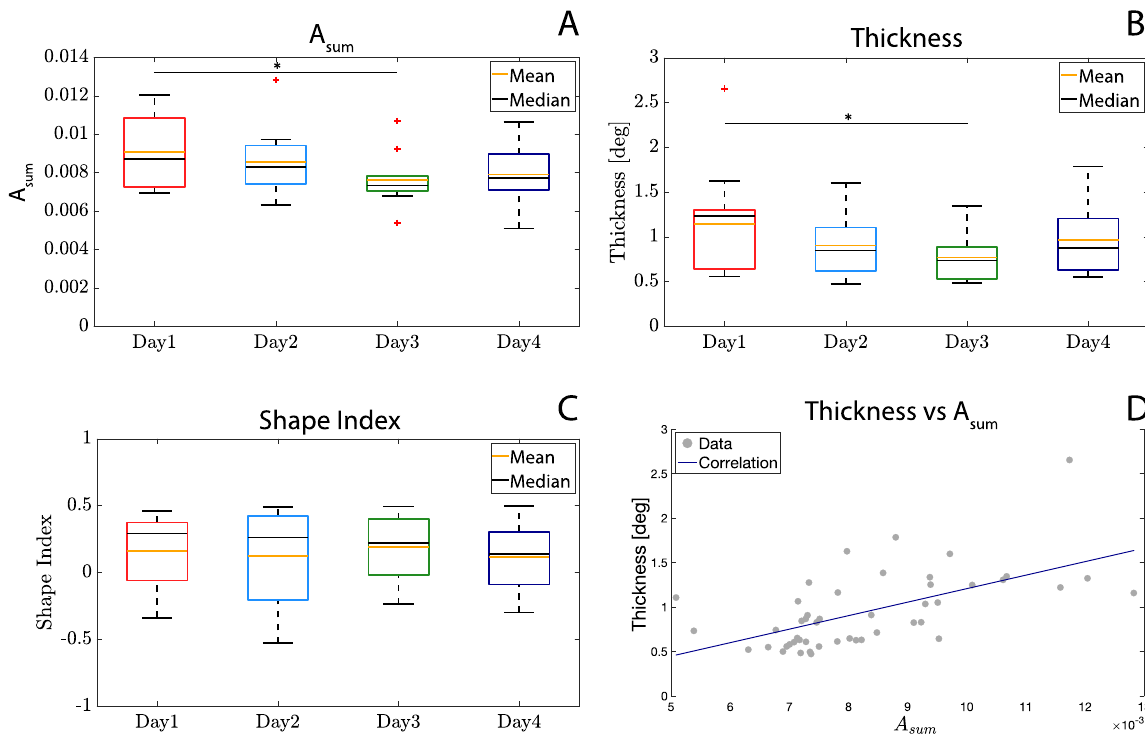
Figure 1. ( A ) Average Task-Space Accuracy A sum (along trials and participants) over the 4 days; ( B ) average Thickness (along trials and participants) over the 4 days, neglecting the discarded outliers; ( C ) Shape Index averaged along trials and participants over the 4 days, neglecting outliers; ( D ) correlation between Thickness and Task-Space Accuracy . Pearson’s R = 0.62 with a p = 3.8 × 10 − 6 . Within box-plots ( A – C ), red crosses represent the data labelled as outliers by the MATLAB™ function boxplot , net of neglected outliers on the basis of Thickness